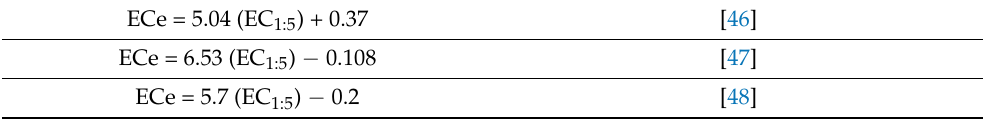
Table 3. Relationships for predicting ECe from measured values of EC 1:5 proposed by some